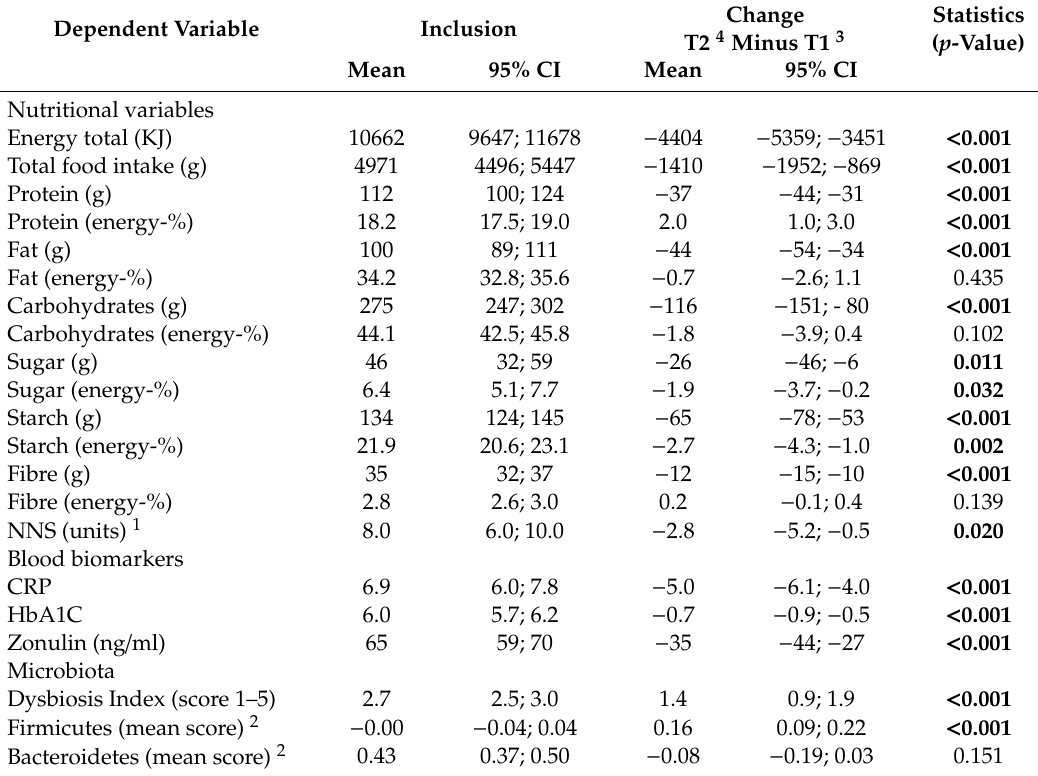
Table 2. The amounts of nutrients (absolute and relative), blood biomarkers and the faecal microbiota at inclusion and changes after the weight-loss interventions. Mixed model adjusted for the means of age and